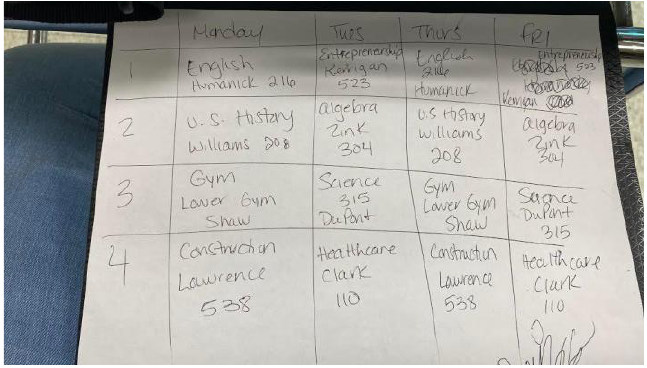
Figure 3. Dealing with the challenges of virtual learning for a participant with ADHD.